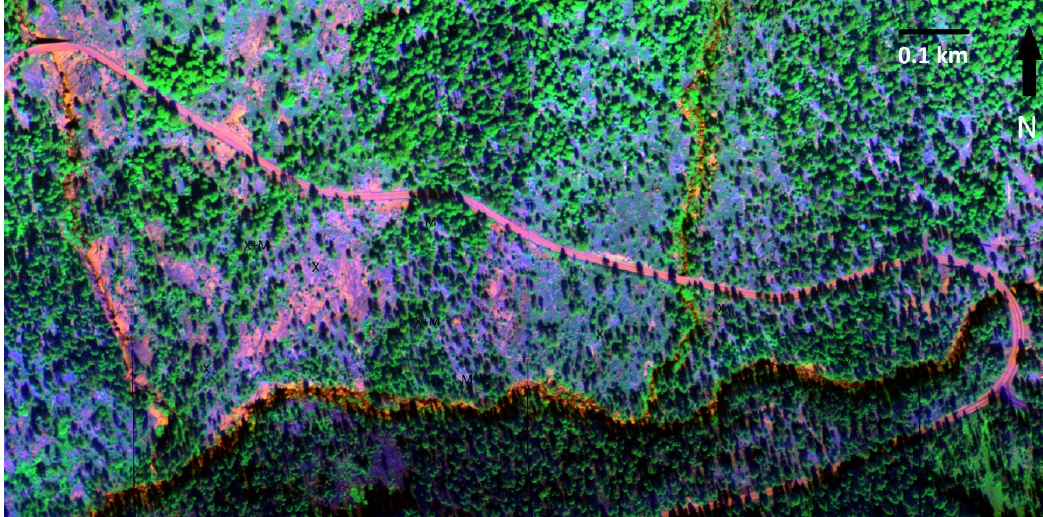
Figure 1. Colorized composite of the intensities of high resolution (R), near-infrared (NIR), and thermal wavelengths of the calibration site on the western slope of south-central Sierra Nevada. The site is bounded by the Marble Fork of the Kaweah River (rusty brown) on the south, and General’s Highway on the north (fuchsia), just west of Lodgepole, California. The darker gray-green rounded trees (see cast shadow) are Jeffrey pine distributed in open rocky areas (xeric (X)), along the riparian corridor and ephemeral seeps (mesic (M)), as well as intermingled X and M trees. A temporal sequence of increasing foliar temperature (THERM) of two mature Jeffrey pines from 10:30 to 12:00 under physiological drought stress and sequential stomatal closure, lower to upper crown, is shown in Figure 2, at a lateral distance of 2.5 km (similar to [60]). The imagery was printed and the location of each intensively studied tree was verified in the field across the calibration site (Figure 1). The imagery was displayed in ArcGIS software [61], with the shaded portion of each tree excluded (Figure 2, right). The upper crown (top of the tree to ½ the radius of the sunlit portion) and upper part of the mid-crown (the exterior ½ radius of the sunlit portion) was segmented. A 2.2 m buffer (1 thermal pixel) was eliminated around the exterior edge of the mid-crown to reduce potential contamination by ground cover. Within each segment, x:y coordinates of sample points were selected using “create random points”, and the intensities of the R, NIR, and THERM were extracted. A subsample of 30 points per crown portion was sufficiently representative, as the mean of 30 points did not statistically differ from that of 130 points (p < 0.05). The crown spectral traits were the reflective intensities of R, NIR, THERM, and two indices, (NDVI), and its inverse, NIR scalar (NIR SC, (R – NIR) / (NIR + R)). The intensity of the wavelengths and indices were reported for the upper crown (e.g., R TOP), the upper surface of mid crown (e.g., R MID), and their difference (e.g., R TOP – R MID, R Δ ). There was a discrepancy in sampling morphological traits in the lower portion of the mid crown (11–13 m) and in the spectral traits in the upper portion of the mid crown (14–15 m). For the purposes of this study, we assumed that the health of the mid crown was similar from lower to upper mid crown [62].